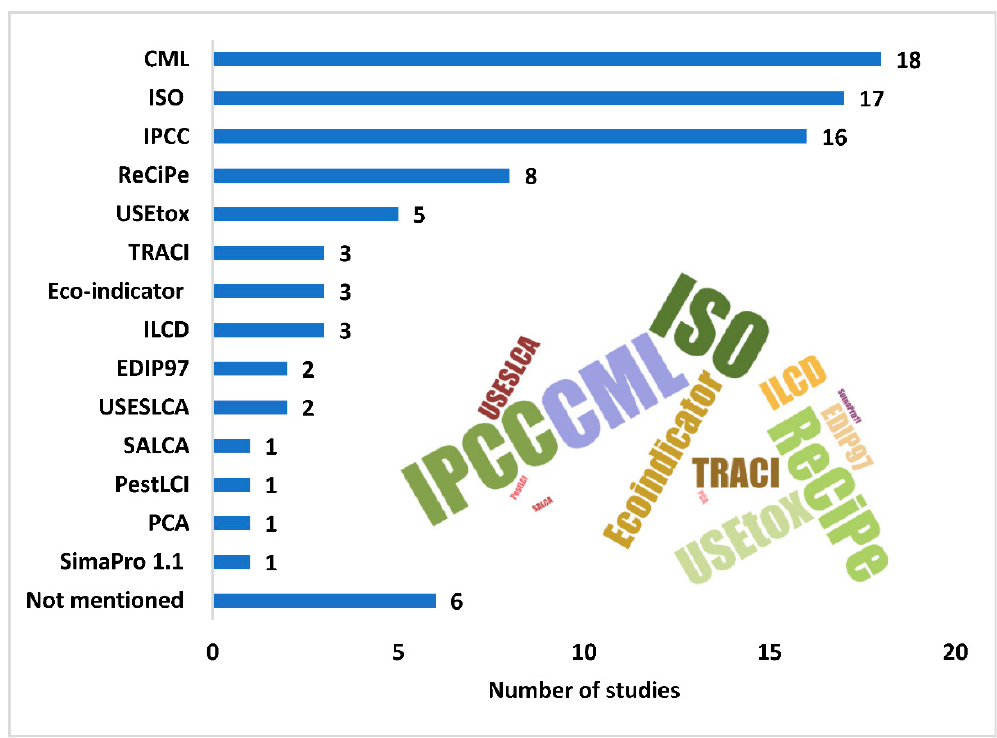
Figure 14. Quantitative and qualitative representation of the frequency of components of the LCIA phase in the reviewed studies.